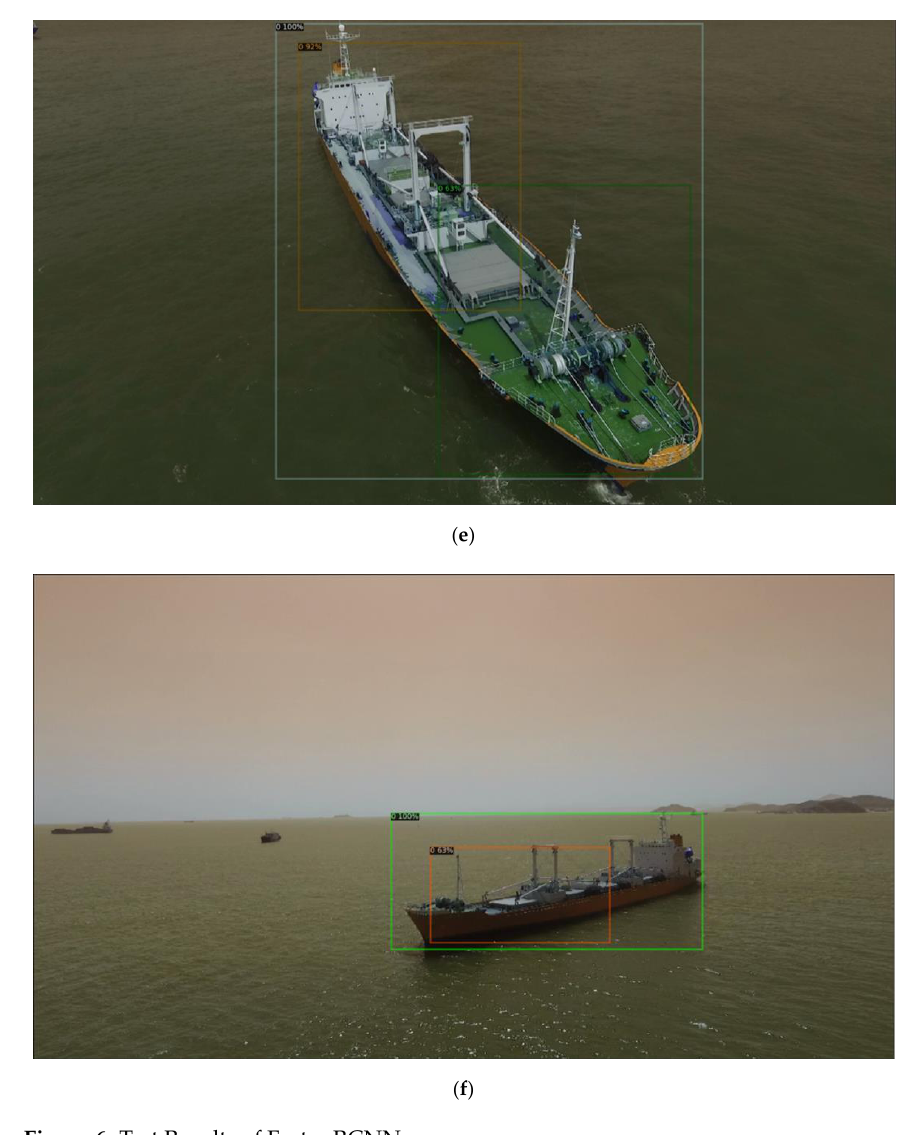
Figure 6. Test Results of Faster